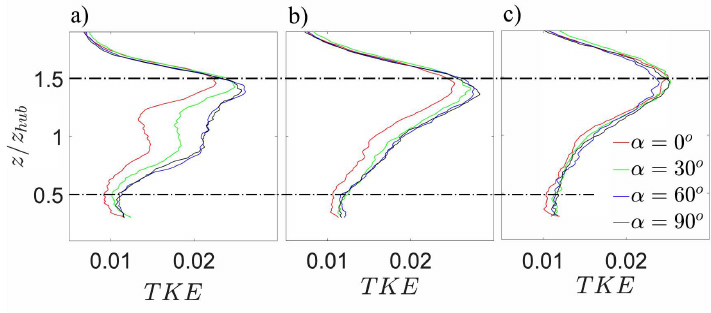
Figure 10. Profiles of turbulence kinetic energy, for the wake flow at x / d T = ( a ) 2, ( b ) 3, and ( c )